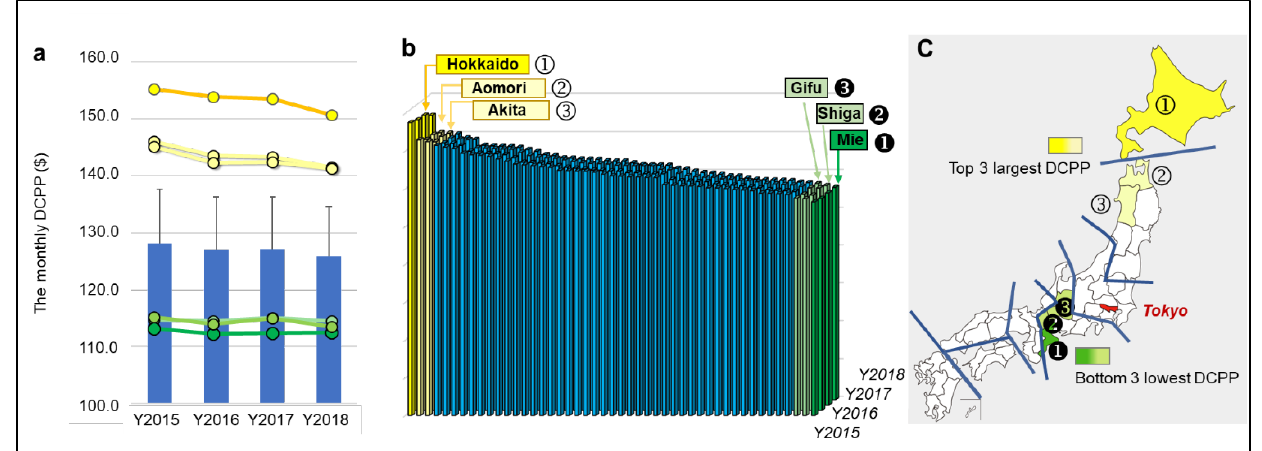
Figure 2. Association between geographic factors and monthly DCPP (dental cost per person). Yellow indicates the top 3 state with higher DCPP, and green indicates the lowest 3 states. ( a ): Monthly average DCPP of 47 states. There is a slight decrease in the monthly average DCPP of 47 states over this time frame, but no statistical significance was observed in this decline. ( b ): Average monthly DCPP in all 47 states. The DCPP of Hokkaido (Top 1) was significantly higher than all other 46 states ( p < 0.01, One-way ANOVA and Tukey HSD test), and Aomori and Akita were higher than the other 42 states ( p < 0.01). In contrast, the DCPP of Mie was significantly lower than the other 42 states ( p < 0.01). ( c ): The bottom three states are in the same local welfare bureaus (Tokaihokuriku-Kinki), and the top three are in the north two bureaus (Hokkaido-Tohoku).